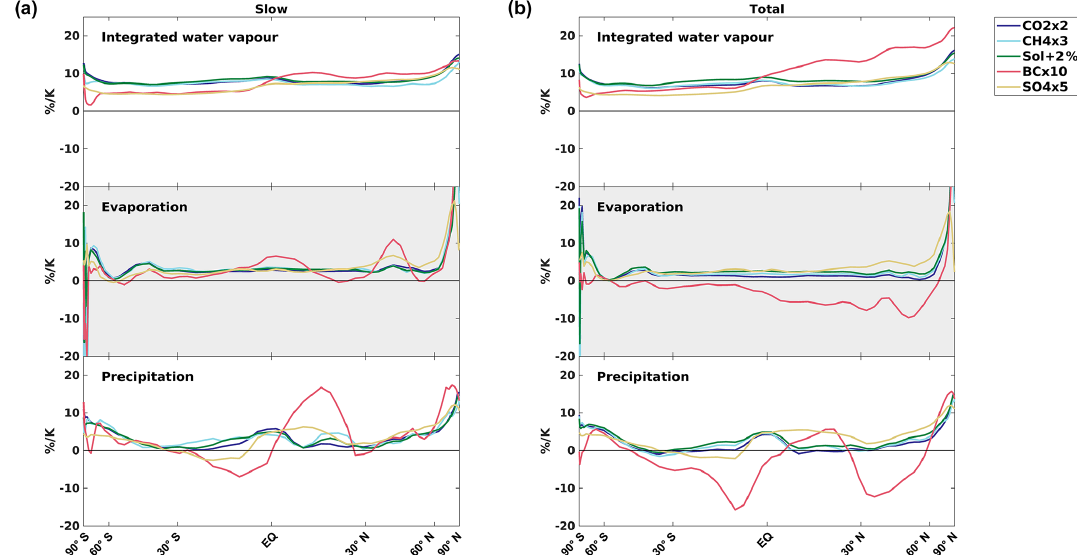
Figure 1. Zonal-mean relative changes (%K − 1 ) in integrated water vapour, evaporation, and precipitation for five different drivers for the (a) slow and (b) total responses, divided by the global- and annual-mean (cid:49)T s induced by each driver, using the mean of the PDRMIP results. In some cases, relative evaporation changes are large at very high latitudes and exceed the scale.